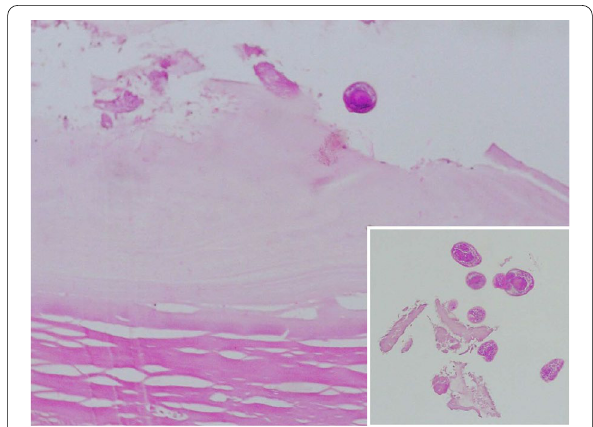
Fig. 3 Histology (HE 40): acellular eosinophilic laminated × membrane lined by a germinal layer with daughter